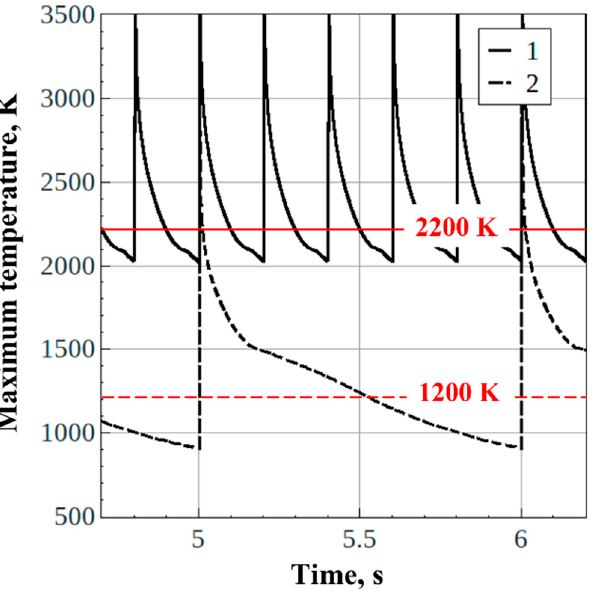
Figure 14. Calculated time histories of the maximum mean temperature in the flow reactor at pulsed detonation gun operation with frequencies of f = 1 and 5 Hz without feed of waste ( T w = 450 K, P = 0.1 MPa). Horizontal lines correspond to the time-averaged mean temperature values in the flow reactor.